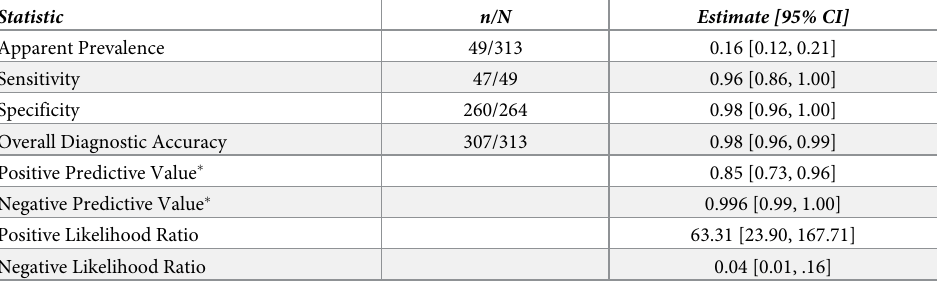
Table 3. Diagnostic Analyzer for Selective Hybridization (DASH) POC PCR diagnostic performance and accu- racy compared to Cepheid Xpert Xpress PCR as “gold standard”.